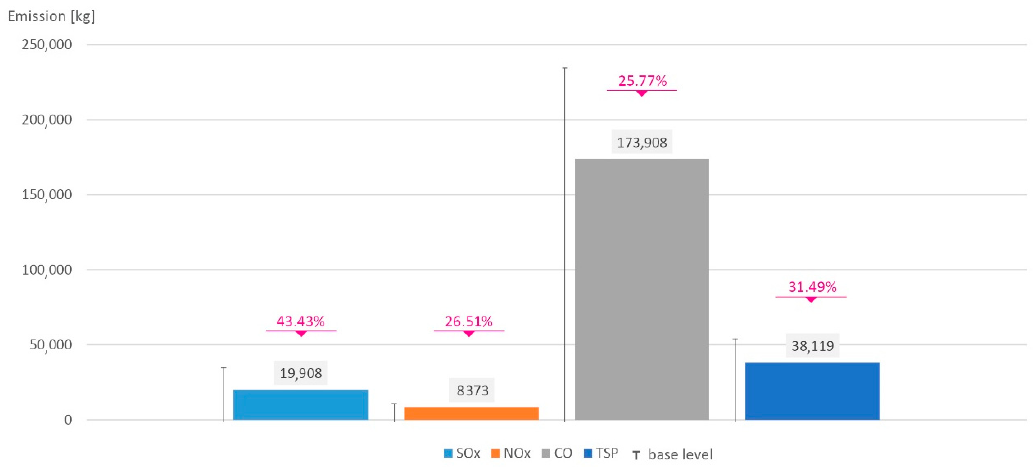
Figure 12. Annual emissions of pollutants in Model 6: 40% coal, 40% biomass, 5% fuel oil, 15% heat pumps and 5% growth of the efficiency of devices.